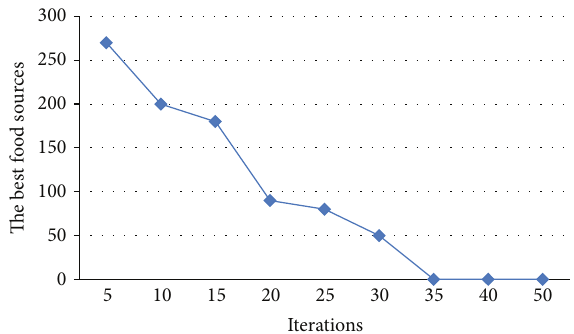
Figure 8: Graphical representation of the best food sources with number of iterations.